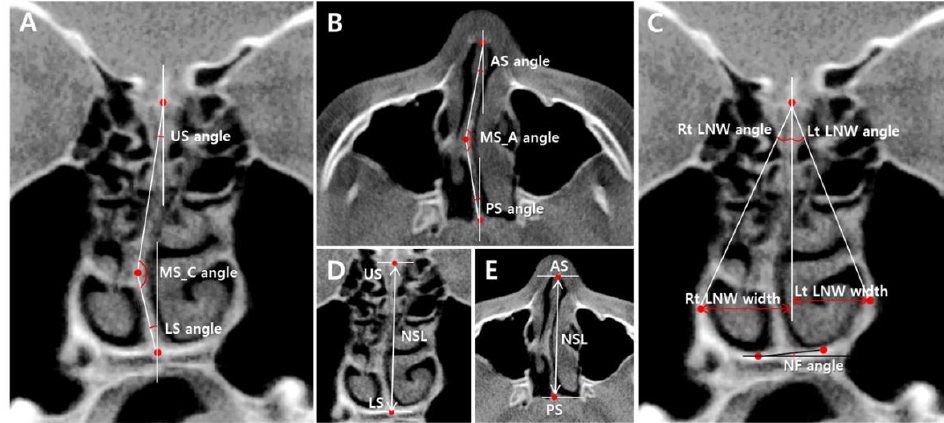
Figure 4. The 3-dimensional values. ( A ) Nasal septal angles (US, MS_C, and LS) in the coronal plane. ( B ) Nasal septal angles (AS, MS_A, and PS) in the axial plane. ( C ) Lateral nasal wall (LNW) angles and widths, and nasal floor (NF) angle. ( D ) Nasal septal length (NSL) in the coronal plane (between US and LS). ( E ) NSL in the axial plane (between AS and PS). Rt, right. Lt, left. Table 1. Definitions of 3-dimensional landmarks.